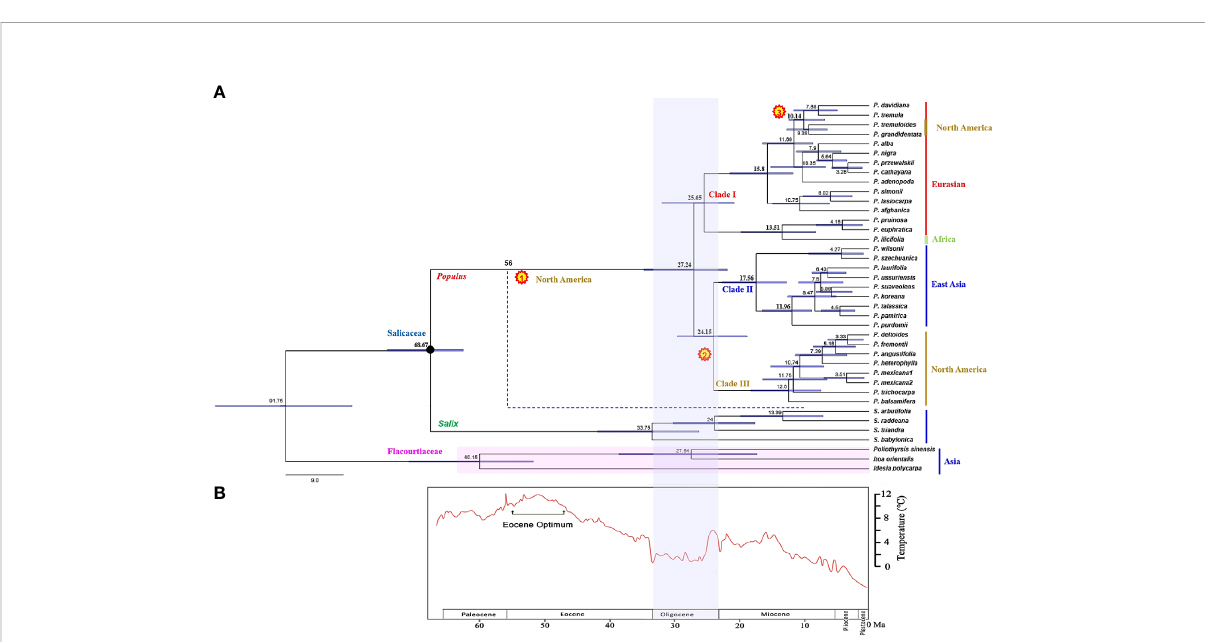
FIGURE 3 (A) Divergence time of Populus estimated from combined chloroplast DNA fragments. The black pie charts indicate the nodes calibrated by the fossils (66 – 93 Ma). The divergence time estimates shown on the nodes are median ages. Numbers in yellow pie charts show three times independently reached into North America events, respectively. The blue dotted line indicates an extinct branch that colonization of North America. The solid line of color next to the taxa names represent the different distribution of species. (B) The depiction of climate change past 60 million years before present is modi fi ed from Zachos et al. (2001).